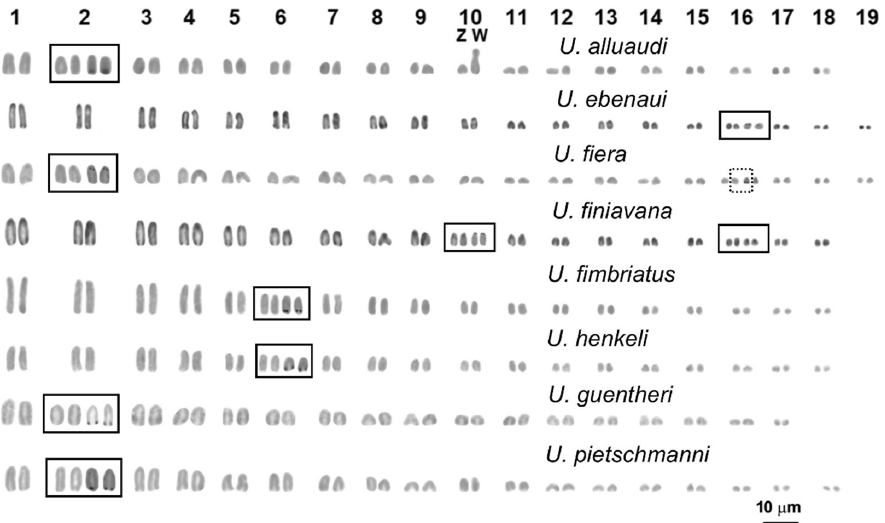
Figure 1. Giemsa stained karyotypes of the studied taxa. Insets include the NOR-bearing pair. In three species ( U. alluaudi , U. guentheri , and U. pietschmanni ), loci of NORs were localised in a telomeric position on the chromosomes of the 2nd pair. In two species ( U. fimbriatus and U. henkeli ), loci of NORs were in a peritelomeric position on the 6th chro- mosome pair. In U. finiavana NORs were on the chromosomes of the 10th and 16th pair, while in U . ebenaui NORs were localised on the chromosomes of the 16th pair. Loci NORs were peculiar in U. fiera , residing on pericentromeric regions of the chromosomes of the 2nd pair and on one of the chromosomes of the 16th pair (Figure 1).